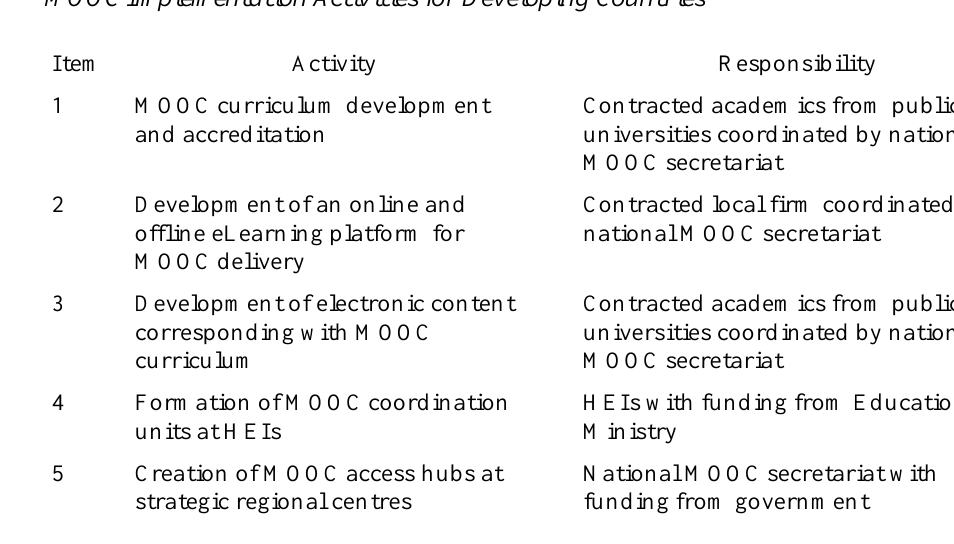
MOOC Implementation Activities for Developing